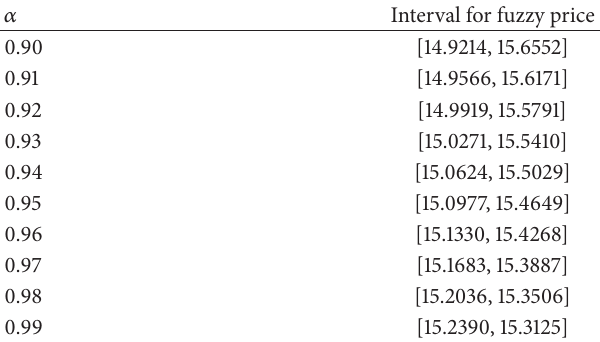
Figure 7: The sensitivity analysis of 𝑆 ∗ and Table 3: The closed interval of 𝛼 -level set of